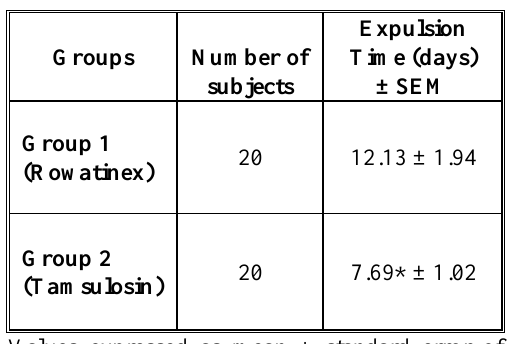
Table 2: The effects of rowatinex and tamsulosin on expulsion time of ureteric stone.